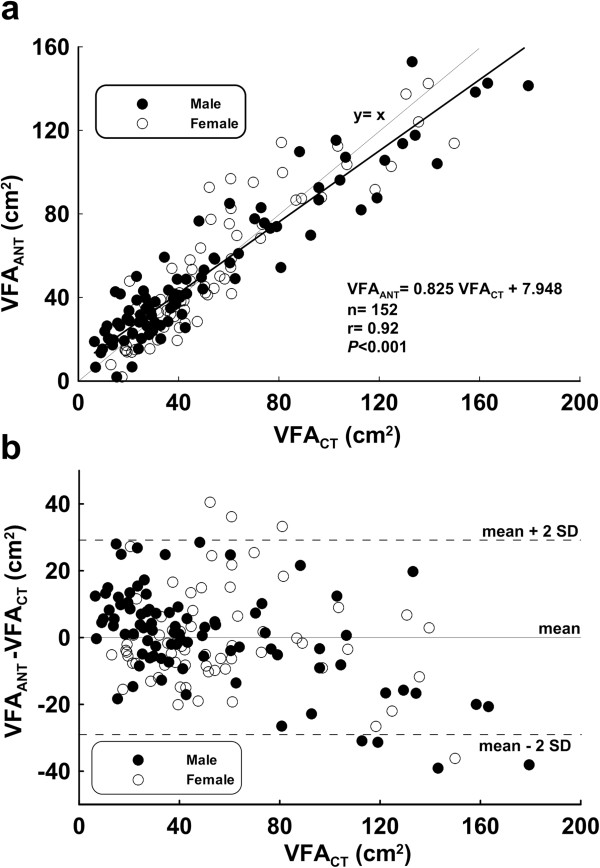
Modeling group (a) Scatter chart and regression line (b) Bland-Altman Plot (mean: 0.0 cm
2
, mean – 2 SD: -28.80 cm
2
, mean + 2 SD: 28.80 cm
2
).